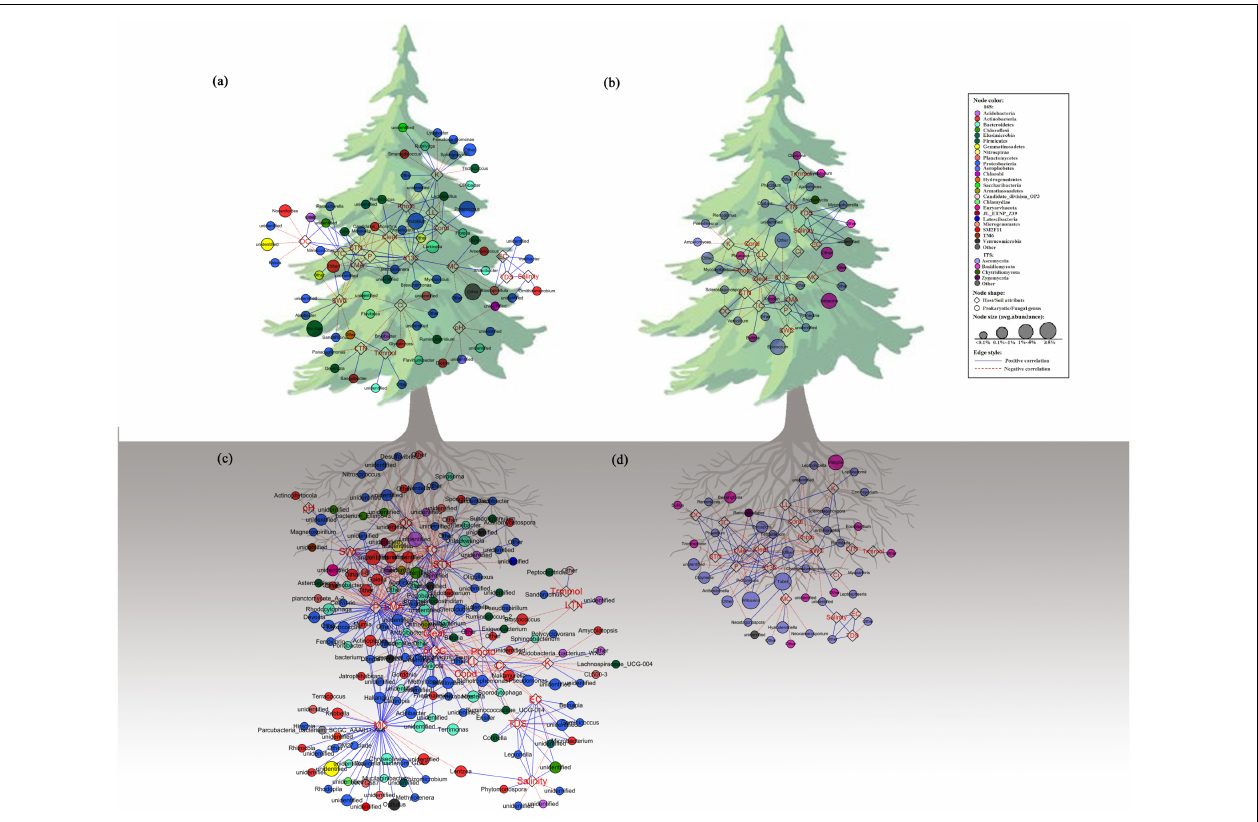
FIGURE 4 | Network analysis showing connectedness between prokaryotic/fungal communities and host/soil factors in the phyllosphere (a,c) and near-root soil (b,d) across the plant holobiont. The blue solid lines represent significantly strong ( > 0.6) positive linear relationship, red dashed lines represent strong ( < –0.6) negative linear relationship. The variables in hexagon boxes show various soil attributes and leaf